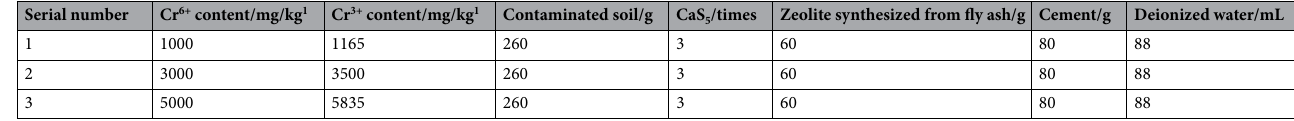
Table 7. Ratio of test samples.